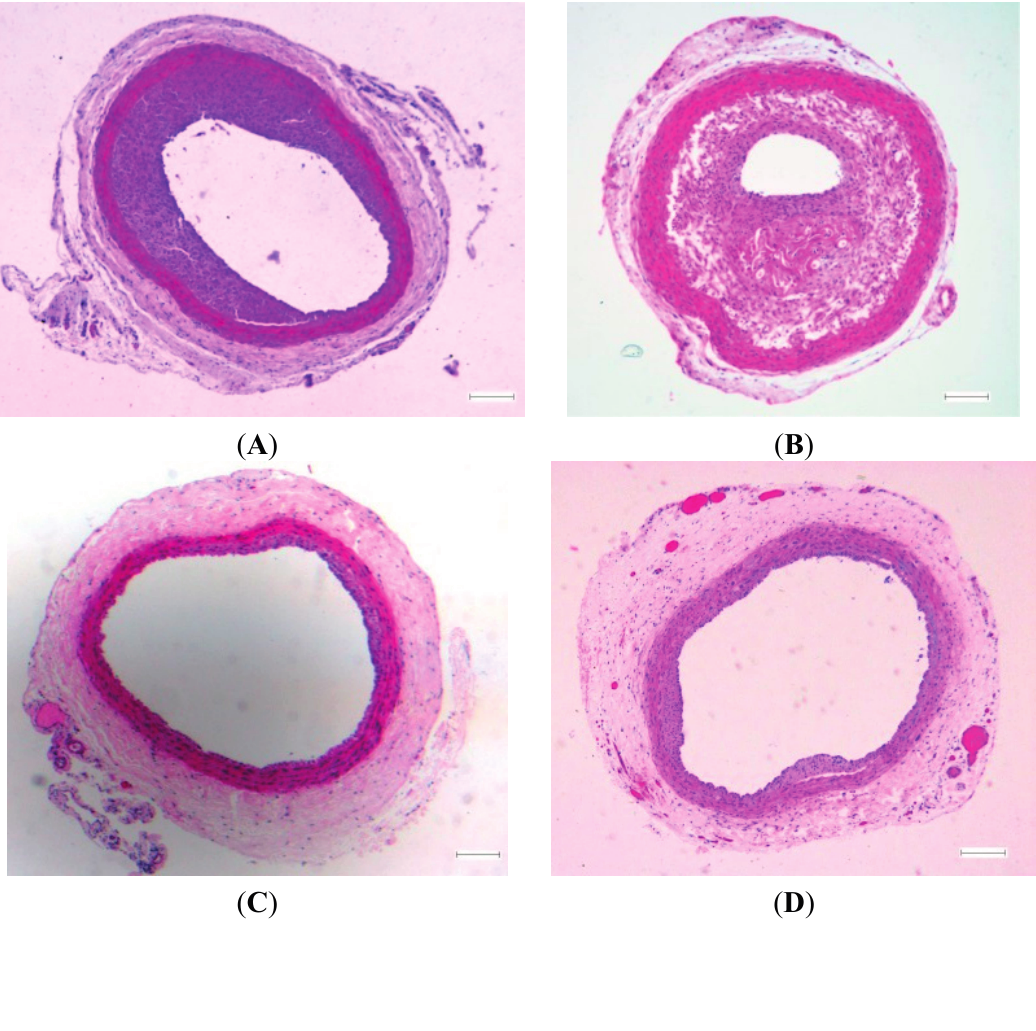
Figure 1. Effect of homocysteine on neointima formation and adventitial hyperplasia of balloon injured arteries. (HE, hematoxylin and eosin stain ×50). The neointimal areas in control group were smaller than that in hyperhomocysteinemia (HHcy) group at day 28 after balloon injury (( A ) control group, ( B ) HHcy group); Adventitial hyperplasia in control group was observed at 7 days of balloon injury ( C ); Adventitial hyperplasia in HHcy group futher increased at the same time point ( D ); and ( E – H ) Effect of homocysteine on luminal area, neointimal area adventitial changes in the normal artery (non-injured carotid artery) and injured arteries. Scale bars = 100 μ m. Δ p < 0.05, ΔΔ p < 0.01 versus normal artery with control diet; # p < 0.05, ## p < 0.01 versus normal artery with L -methionine-induced HHcy group; * p < 0.05, ** p < 0.01 versus control group of the same time